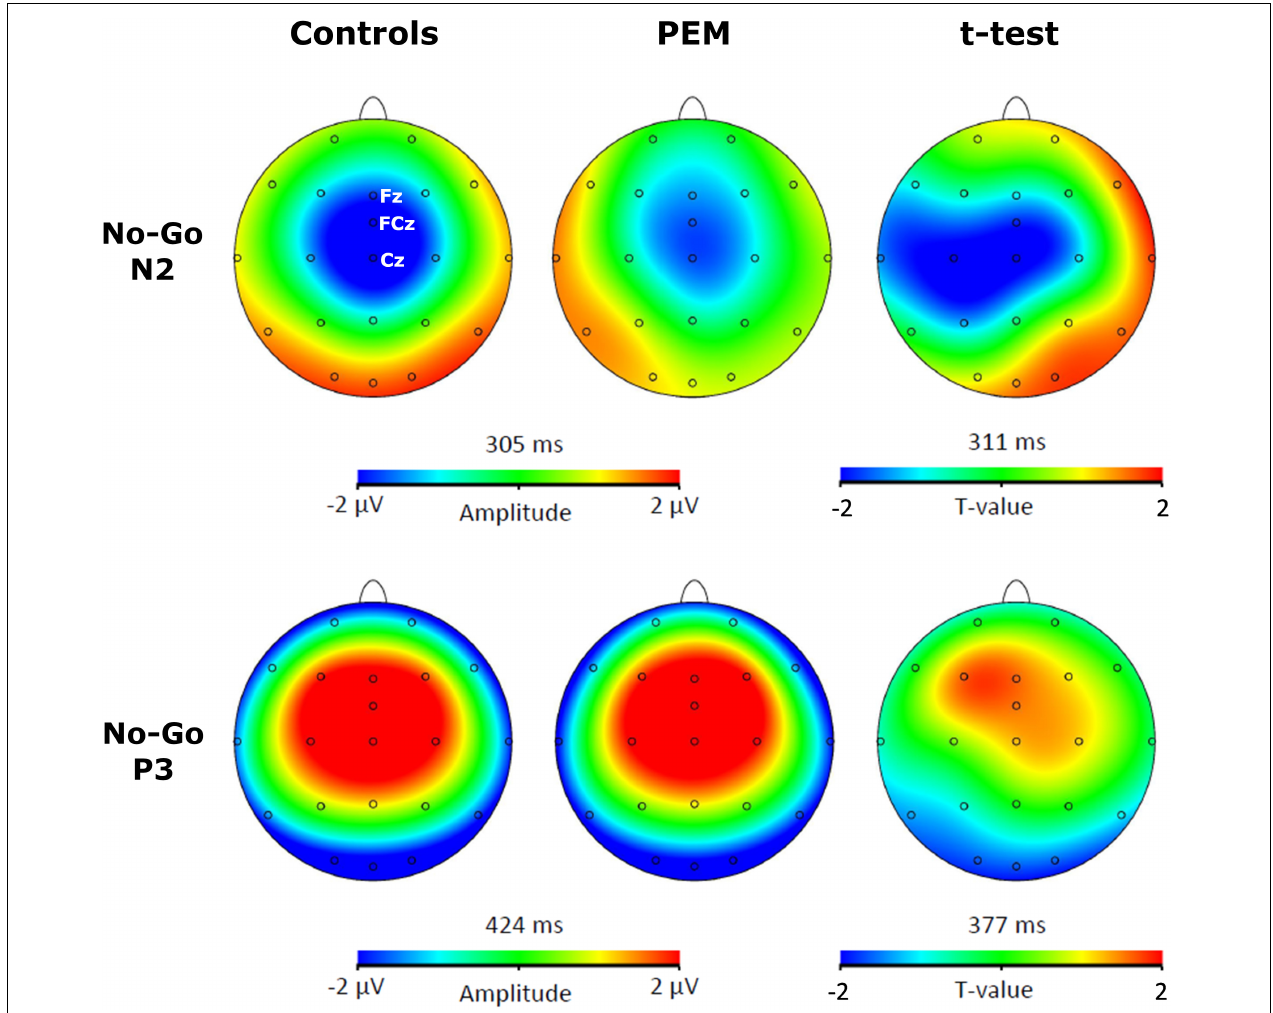
FIGURE 1 | Topographic activation and topographic t -test (not corrected) of the difference of activation between protein-energy malnutrition (PEM) and control groups during No-Go condition [ t (51) > 2.008, p < 0.05].